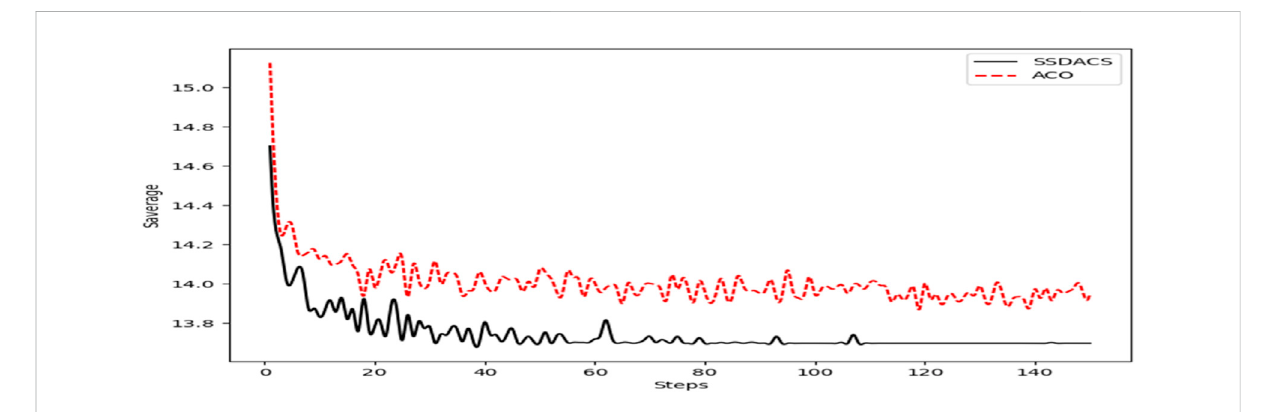
FIGURE 10 The comparison of the convergence process of S average among DSSACS and ACO.